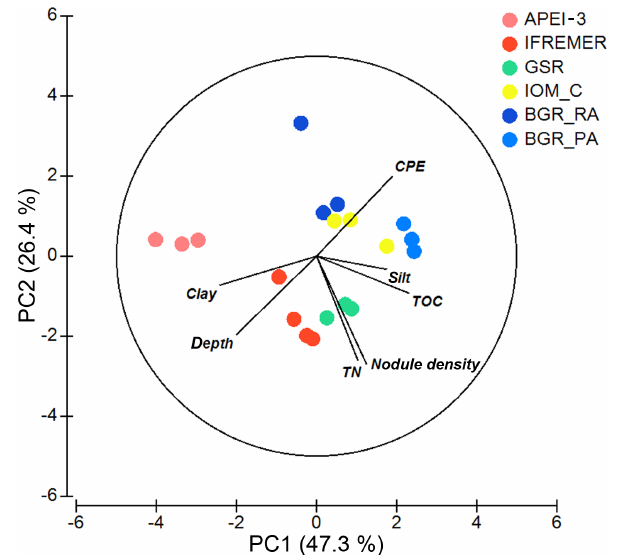
Figure 2. PCA plot of the different areas according to environmen- tal conditions. All variables were normalized prior to analysis. Note that silt and clay content were log transformed to account for skew- ness in the data. Numbers along PCA axes represent the total varia- tion percentage explained by that